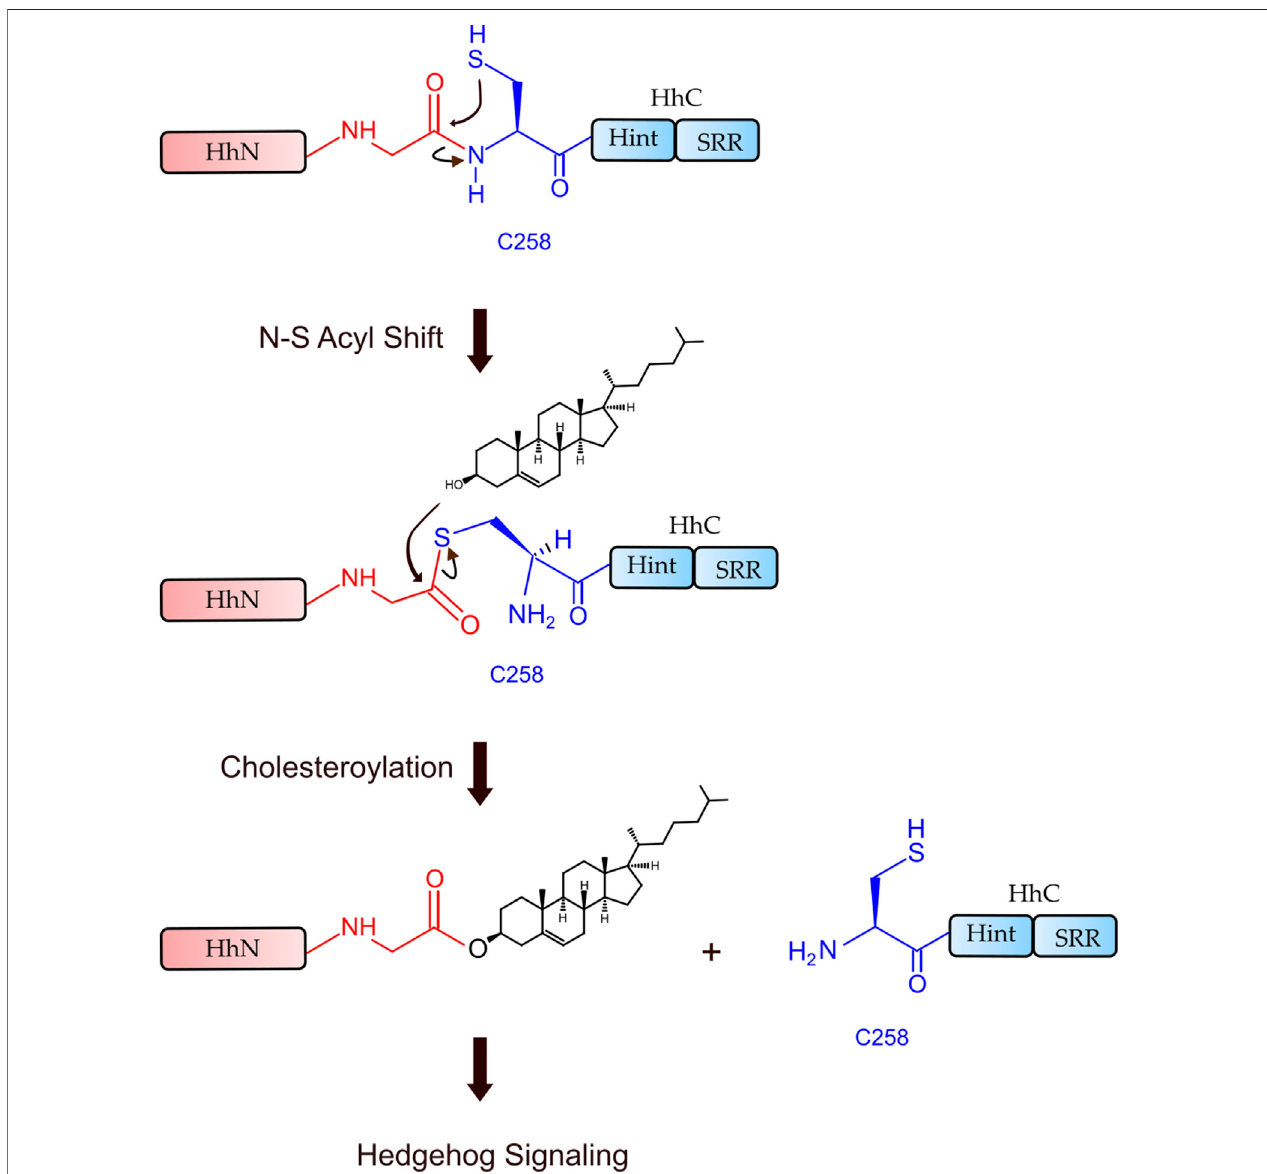
FIGURE 1 | Hh autoprocessing. Hedgehog autoprocessing and the generation of Hh ligand involves two key steps: N-S Acyl Shift and Transesteri fi cation .